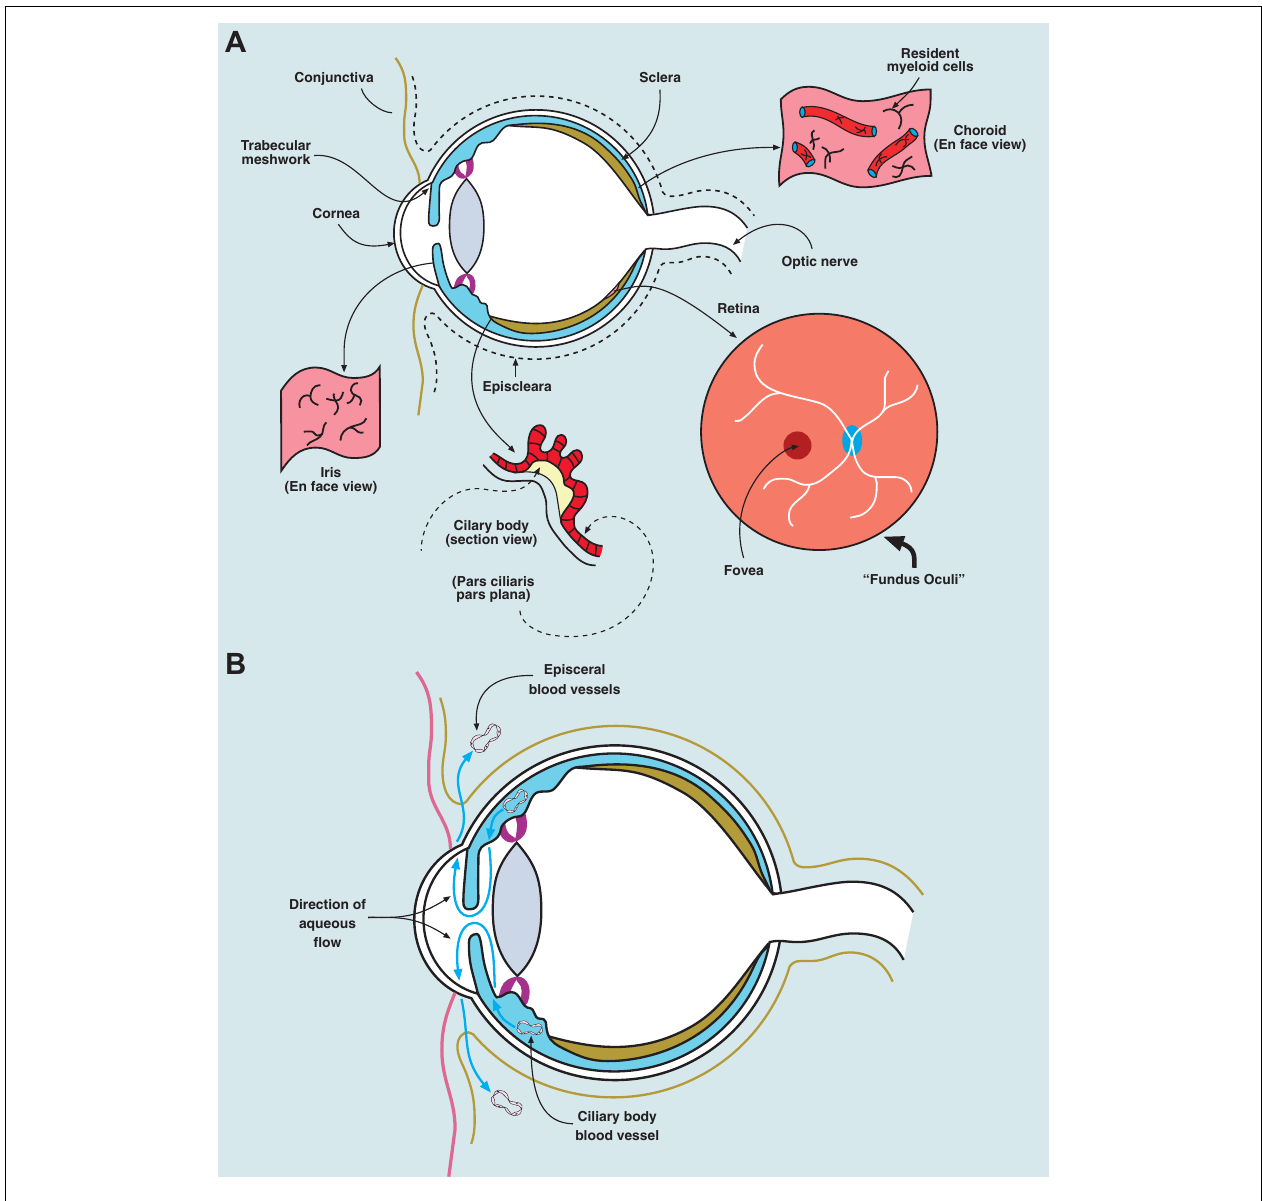
and is highly vascular (seen in section and en face views in the figure).The retina contains few conventional resident myeloid cells, but has a population of microglial cells (see text). Normal ocular tissues are devoid of lymphocytes.The cornea contains a population of passenger leukocytes mostly in its peripheral rim as well as some lymphatics in this region connecting with lymphatics in the conjunctiva. (B) Eye health is dependent on having a normal intraocular pressure, which is maintained between 12 and 20 mm Hg by the flow of aqueous fluid from the posterior chamber of the eye (the space between the posterior surface of the iris and the anterior surface of the lens) and the anterior chamber (the space between the posterior surface of the cornea and the anterior surface of the iris).The vitreous cavity is the intraocular compartment behind the lens and in front of the retina. Aqueous fluid is secreted by the epithelial cells of the ciliary body into the posterior chamber and flows through the pupil of the iris into the anterior chamber to drain through the trabecular meshwork at the angle of the eye between the iris and the cornea, into the subconjunctival space, to be finally removed by interstitial fluid flow into the episcleral veins and the subconjunctival